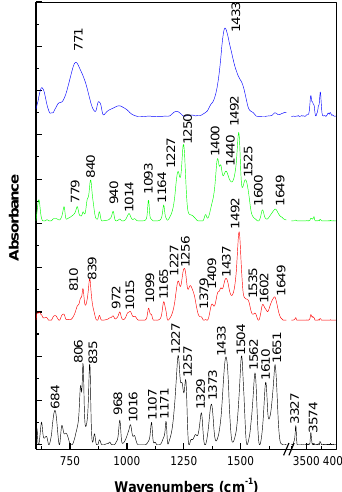
Figure 7. The IR spectra of AC before ( black curve) and after the interaction with NaOH, when the AC: NaOH weight ratio is equal to 4.2 ( red curve) and 0.4 ( green curve), the samples being subsequently exposed to UV light for 140 min. Blue curve corresponds to the IR spectrum of NaOH.